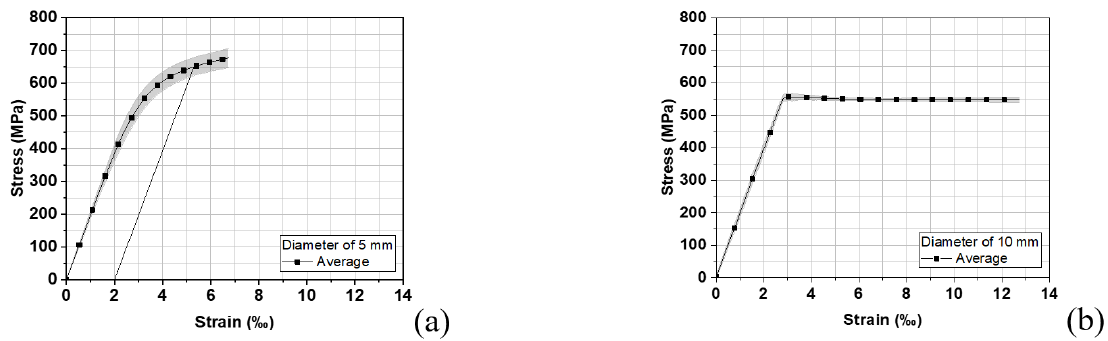
Figure 12. Stress versus deformation of materials: (a) stirrups and (b) steel of longitudinal